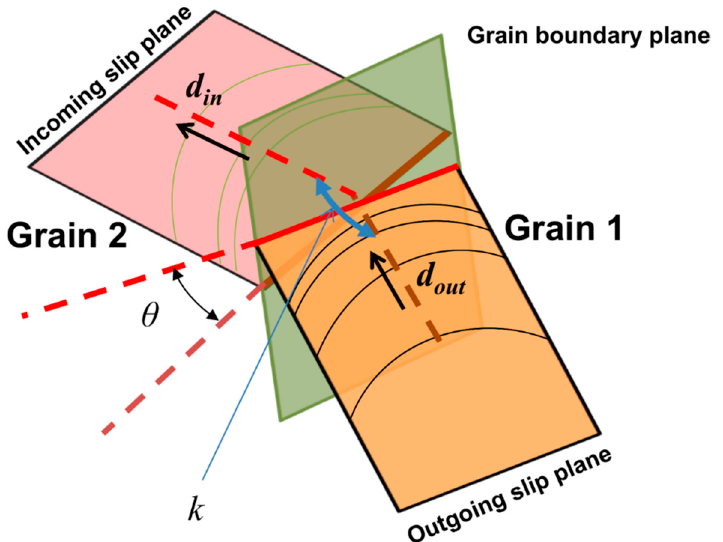
Figure 1. Schematic of slip transmission across grain boundary ( θ is the angle between the normal direction of the incoming slip plane and the outgoing slip plane; k represents the angle between the incoming slip direction d in and the outgoing slip direction d out ).